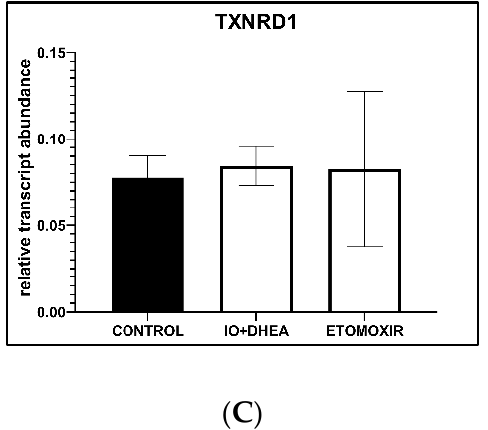
Figure 6. The effect of glucose (IO+DHEA) and fatty acid (ETOMOXIR) metabolism inhibition on the selected gene expression levels (mRNA) in the cumulus cells. The results are shown as a transcript abundance relative to the geometric mean of reference genes (means ± SEM). *— p ≤ 0.05, **— p ≤ 0.01: ( A ) genes involved in glucose metabolism; ( B ) genes involved in fatty acid metabo- lism; ( C ) genes involved in oxidative stress protection.